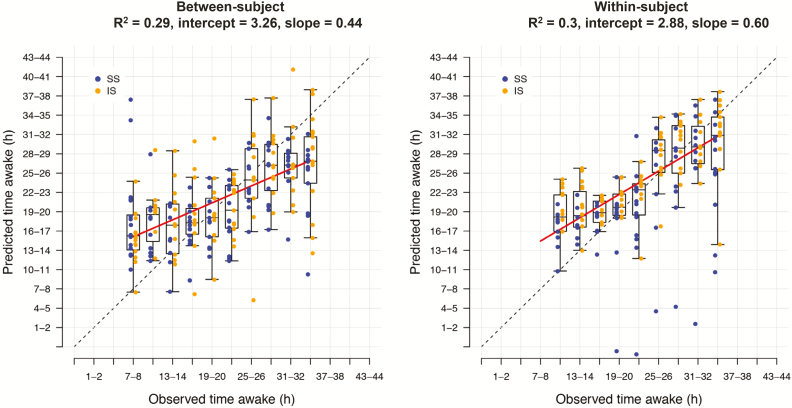
Prediction performance for “time awake” between- and within-subject. Prediction of “time awake” from one (between-subject) or two (within-subject) transcriptome samples. Blue: samples taken following 1 week of sufficient sleep; gold: samples taken following 1 wk of insufficient sleep. Dashed line indicates the line of unity. Red line indicates a linear regression of the relationship of predicted and observed. Data shown is based on the final “all features” elastic net model trained on all samples within the “UPUS” training set and applied to all samples within the corresponding independent validation set.